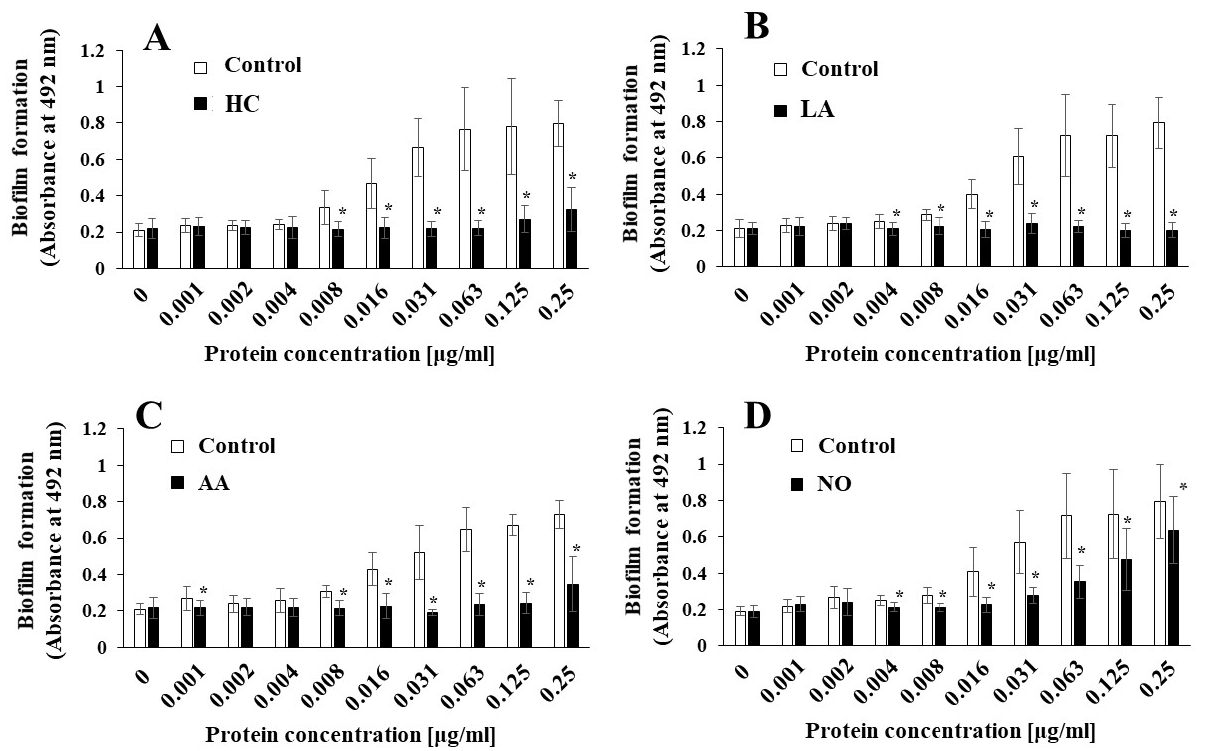
Figure 5. Role of Gtfs for effects of initial pH condition on the MVs-dependent biofilm formation. Biofilm formation of S. mutans UA159 gtfBC - was quantitatively assessed in TSB with 0.25% sucrose with various concentration of MVs from S. mutans SMU833 - in initial pH 6.0 condition prepared with HCl ( A ), LA ( B ), and AA ( C ), and initial pH 8.0 condition prepared with NO ( D ). The data indicate the mean ± SD of three independent experiments. The asterisks indicate a significant difference between the groups (*: p < 0.05, MVs in control condition vs MVs in initial pH 6.0 and 8.0